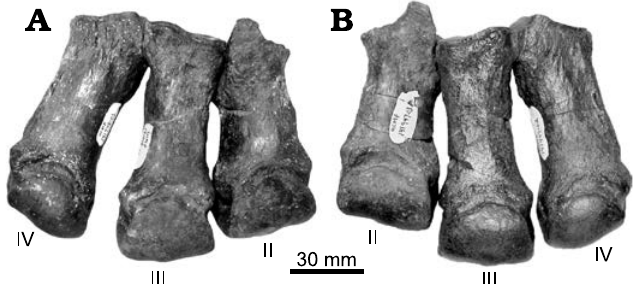
Fig. 8. Articulating right and left hind feet elements of chalicotheriid perisso- dactyl Moropus merriami Holland and Peterson, 1914, from locality UCMP V74103, Eastgate, Churchill County, Nevada, USA; early Barstovian middle Miocene. A . UCMP 141948-02, -01, -03, right metatarsals IV–II. B . UCMP 141947-03, -01, -02, left metatarsals II–IV).